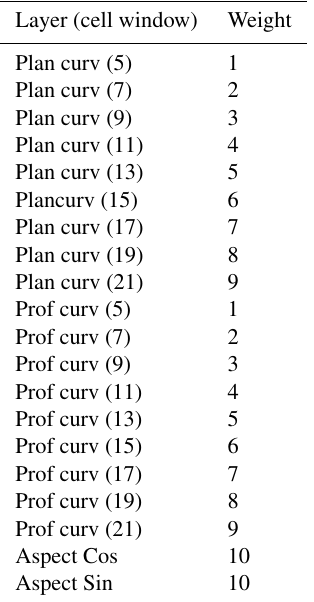
Table 1. Weights assigned to each layer implemented in the eCog- nition developer software for the multiresolution segmentation al-